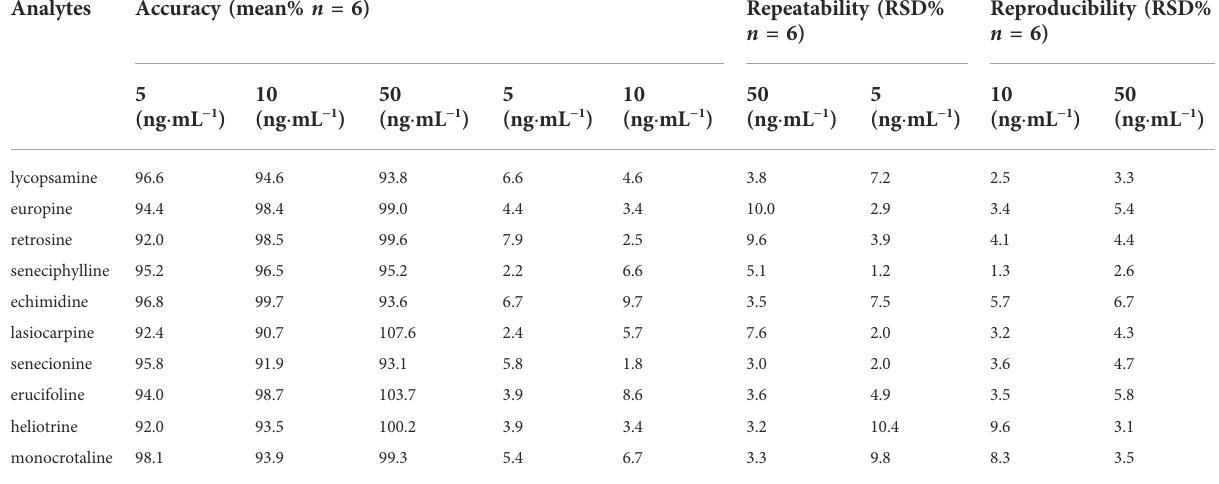
TABLE 5 Accuracy and precision results summary for spiked scented tea samples. Analytes